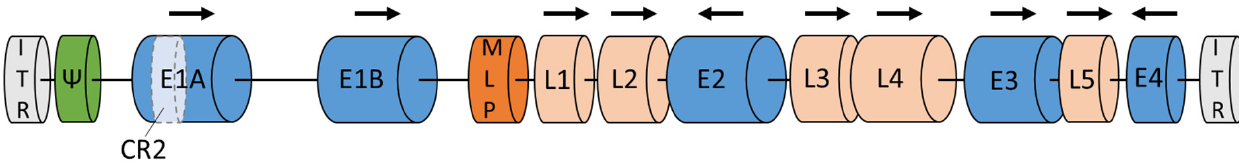
Figure 1. Adenoviral genome. Legend: E1–E4—early genes; L1–L5—late genes; ITR—inverted ter- minal repeat; MLP—major late promoter; Ψ —packaging sequences. Based on GenBank: